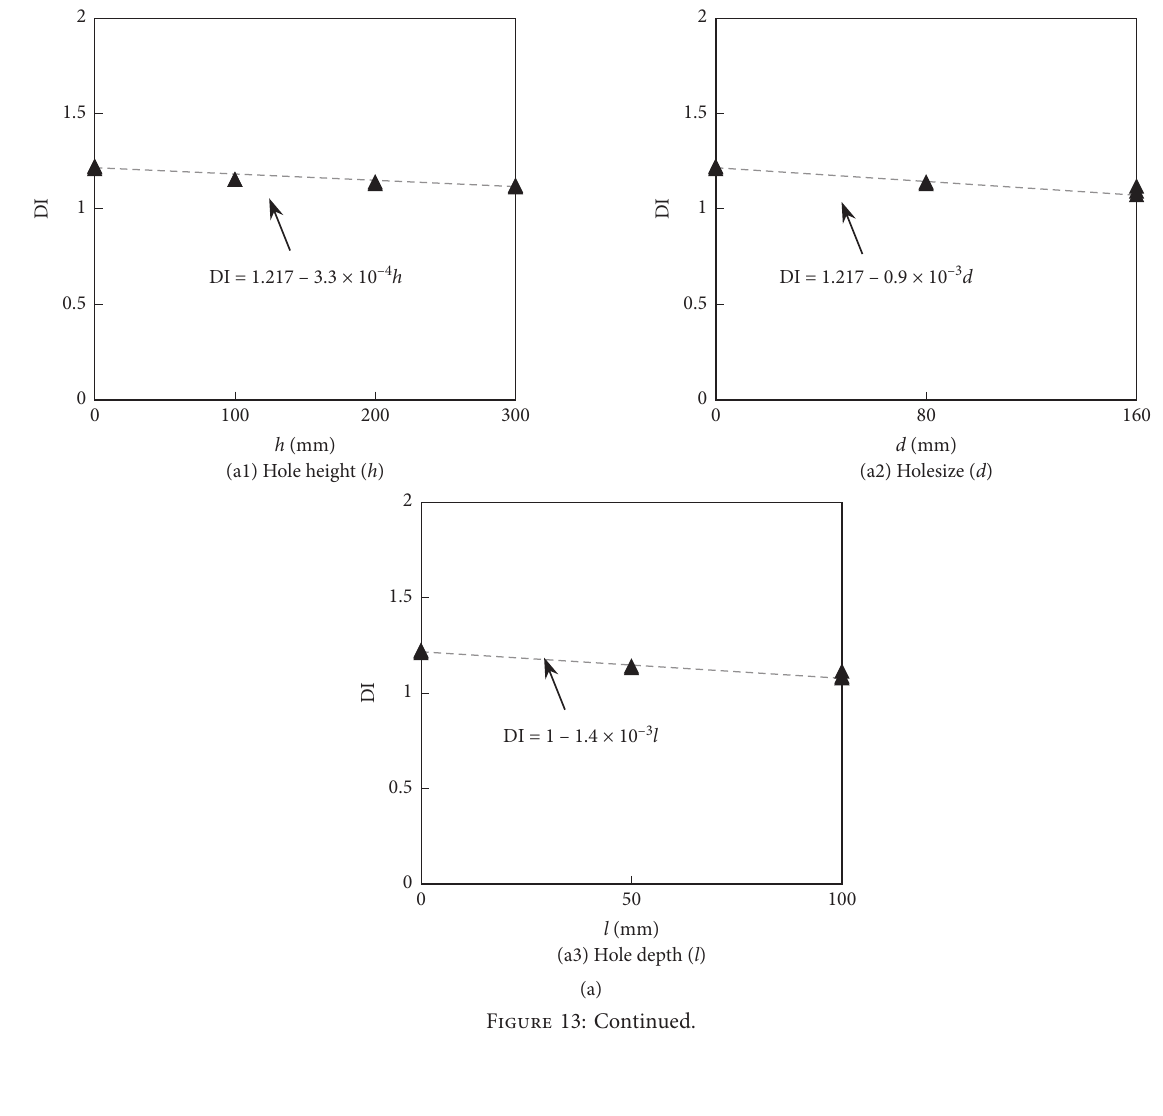
DI = 1.217 – 3.3 × 10 –4